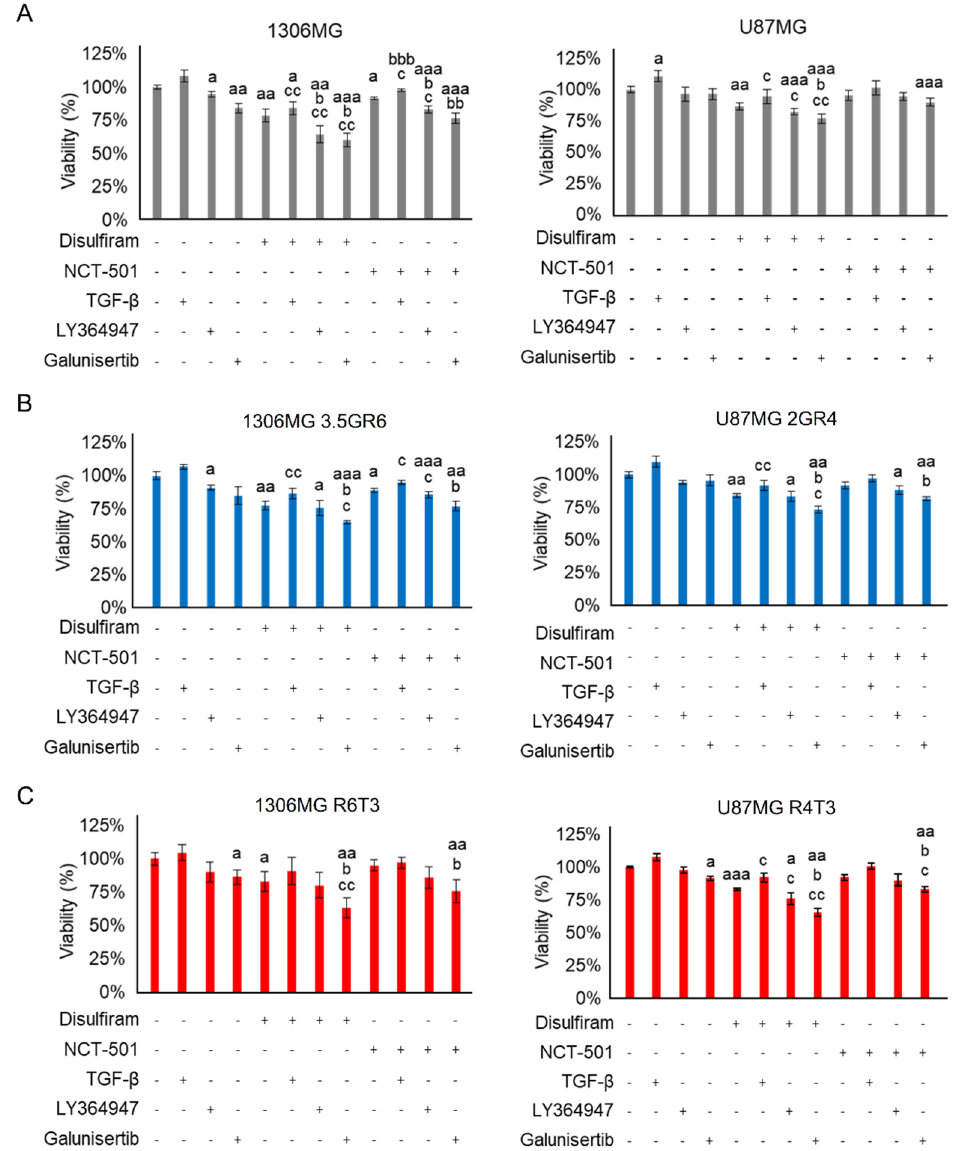
Figure 6. Combining ALDH and TGF- β inhibition represses cell growth. A Trypan blue exclusion assay was used to evaluate the cell proliferation. 150 nM DSF and 100 nM NCT-501 for U87MG, 8 µ M DSF and 300 nM NCT-501 for 1306MG, 10 ng/mL TGF- β , 4 µ M LY364947, and 100 µ M Galunisertib were used to treat cells for 24 h. The “+” means with the treatment while the “-” means without the treatment. ( A ) Histograms showing the cell viability of parental 1306MG and U87MG; N = 4; ( B ) histograms showing the cell viability of radiation-resistant 1306MG 3.5GR6 and U87MG 2GR4; N = 5 for 3.5GR6; N = 3 for 2GR4; ( C ) histograms showing the cell viability of radiation-TMZ-resistant 1306MG R6T3 and U87MG R4T3; N = 3; mean ± SEM; a refers to a comparison with the 0 control; b refers to a comparison with sole DSF or NCT-501; c refers to a comparison with sole TGF- β or LY364947 or Galunisertib; a, b, c, p < 0.05; aa, bb, cc, p < 0.01; aaa, bbb, p < 0.001.